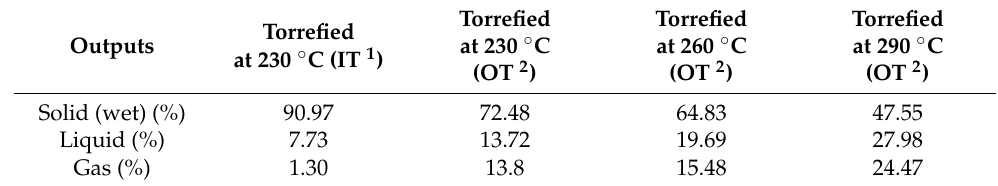
Table 5. The total yield of torrefied products in three